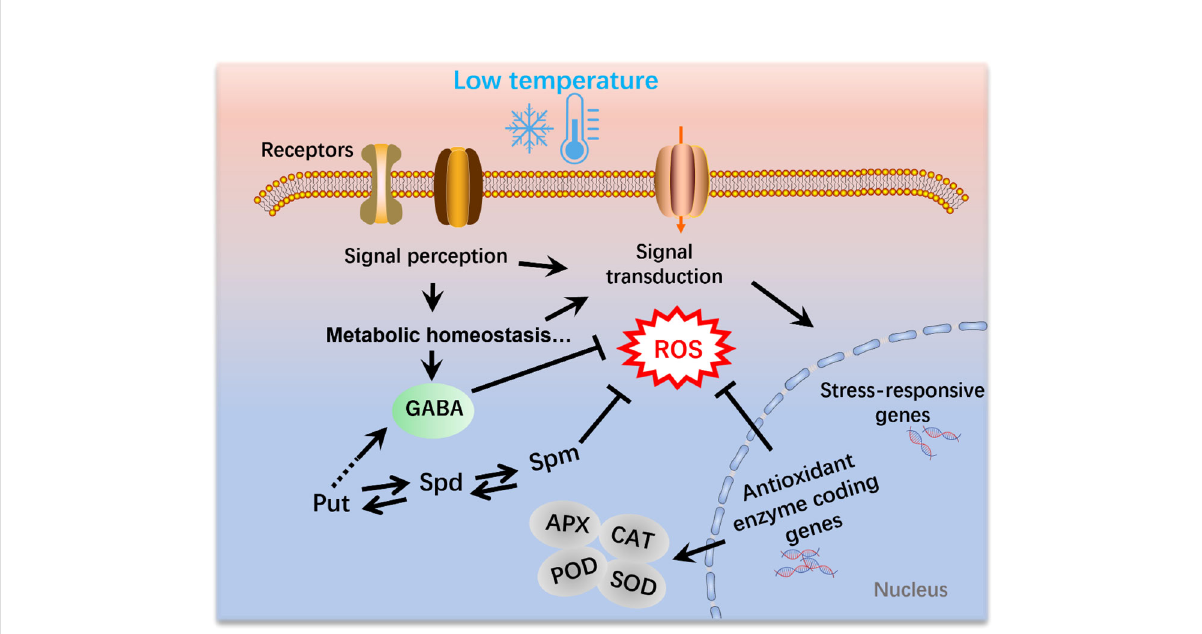
FIGURE 2 Polyamines and g -aminobutyric acid (GABA) mediate the mitigation of reactive oxygen species (ROS) production under low-temperature conditions in plants. Cold signals are sensed by receptors and thereby induce a range of physiological, biochemical, and metabolic